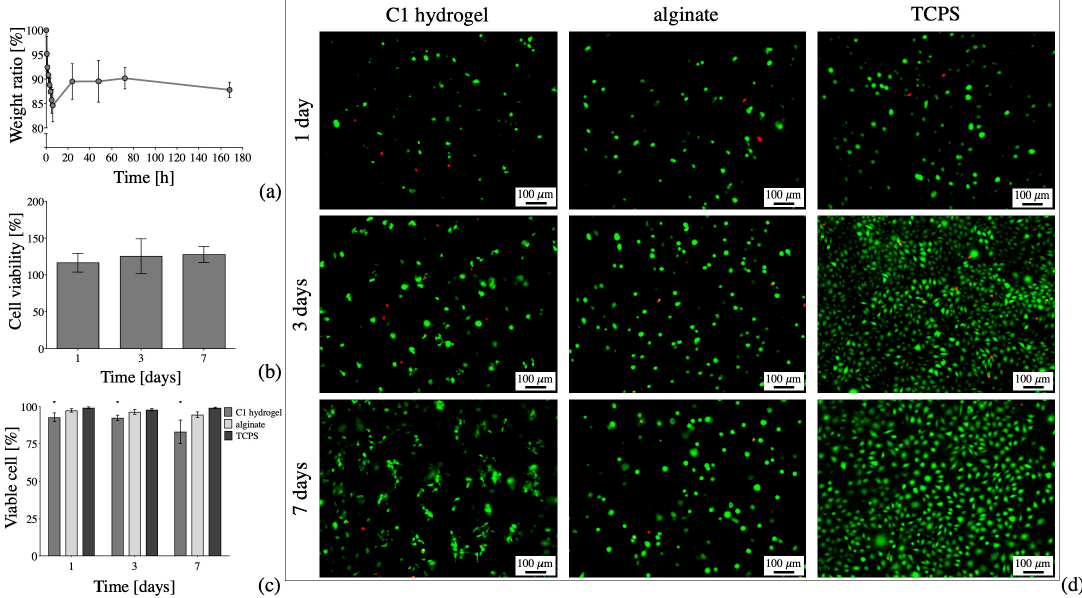
Figure 7. In vitro tests of C1 hydrogels. ( a ) Percentage weight ratio of C1 hydrogel immersed in culture medium at 37 °C, up to 7 days (i.e., 168 h). ( b ) Percentage L929 cell viability of cell cultured in culture medium eluates in contact with C1 for 1, 3 and 7 days, compared to cells cultured in culture medium (i.e., control). ( c , d ) In vitro direct cytocompatibility tests of cells embedded in C1 , in alginate/Ca 2+ hydrogel (i.e., hydrogel control) and seeded on tissue culture plastic (i.e., tissue culture plastic (TCPS) as control): ( c ) percentage of viable L929 cells (* p < 0.05, comparing a sample to the others at the same time point) and ( d ) representative LIVE/DEAD staining images (scale bar: 100 μ m).